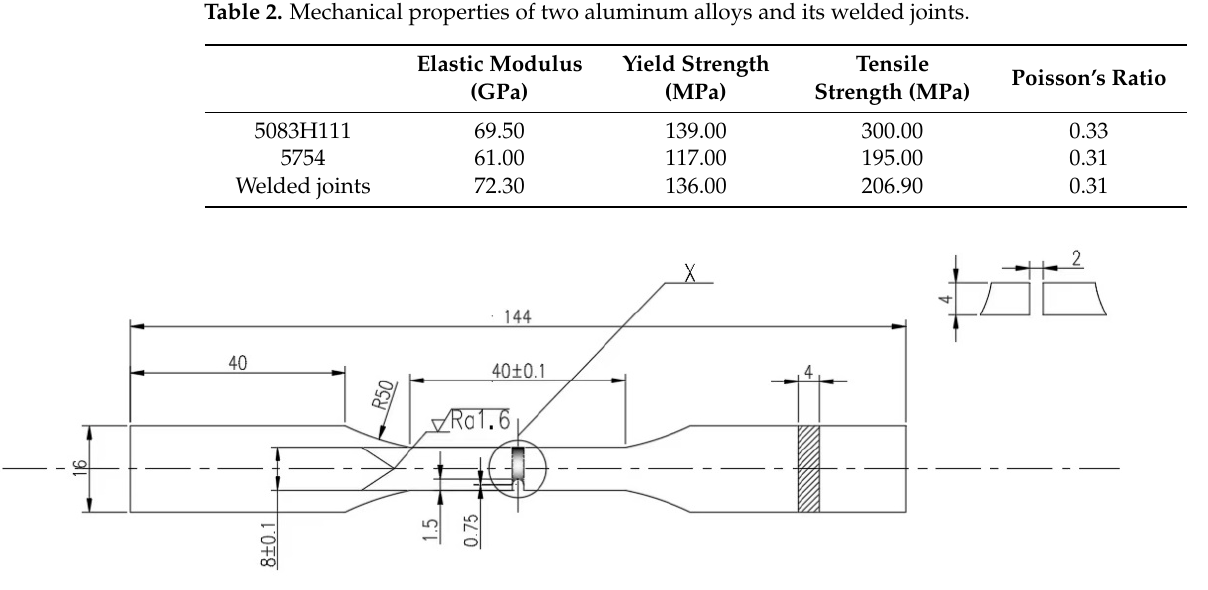
Figure 1. Dimension of dissimilar lightweight materials welded joint with precrack (unit in mm).